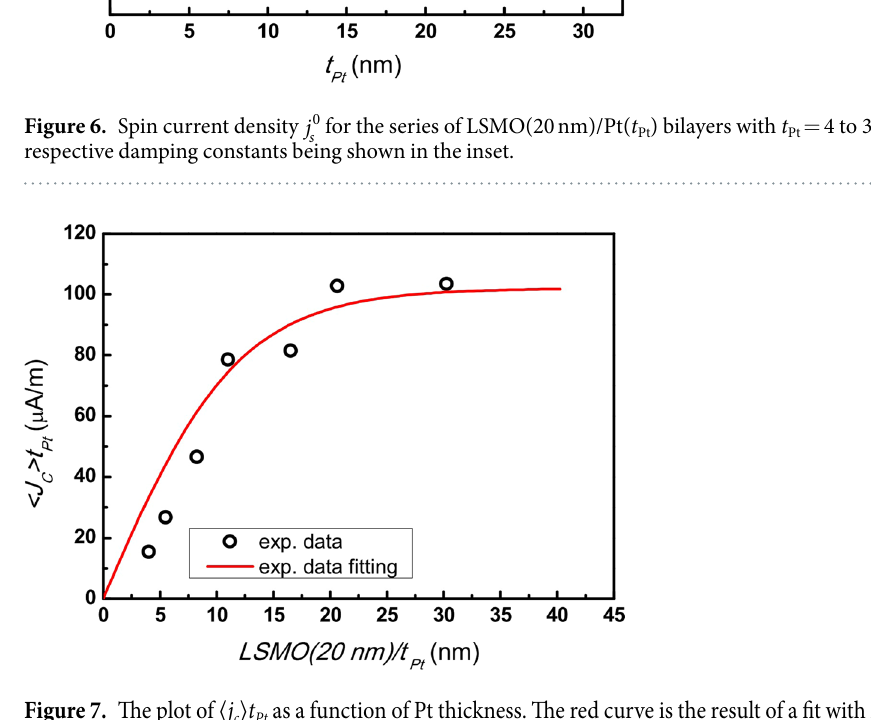
Figure 7. The plot of 〈 j t as a function of Pt thickness. The red curve is the result of a fit with Eq. 10, with c 〉 Pt an assumption that the spin diffusion length remains constant despite the enhanced resistivity of Pt with a thickness smaller than 11 nm. The fitting yields a spin diffusion length of Pt to be 5.9 ± 0.5